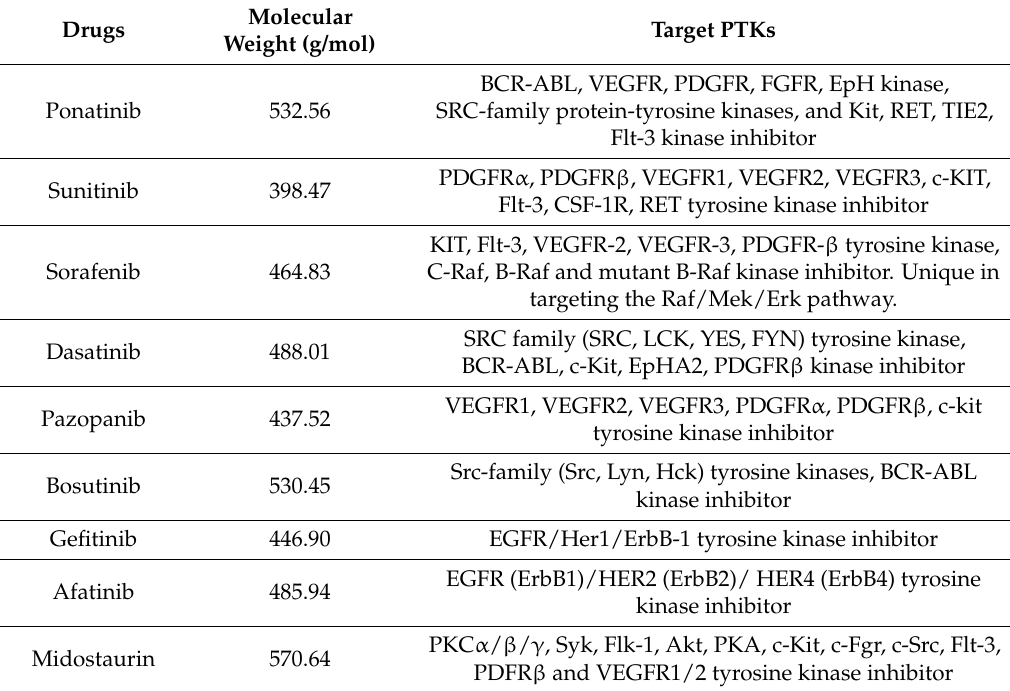
Table 1. Classification and function of nine protein tyrosine kinase (PTK) inhibitors used in this study. Molecular Drugs Weight (g/mol)